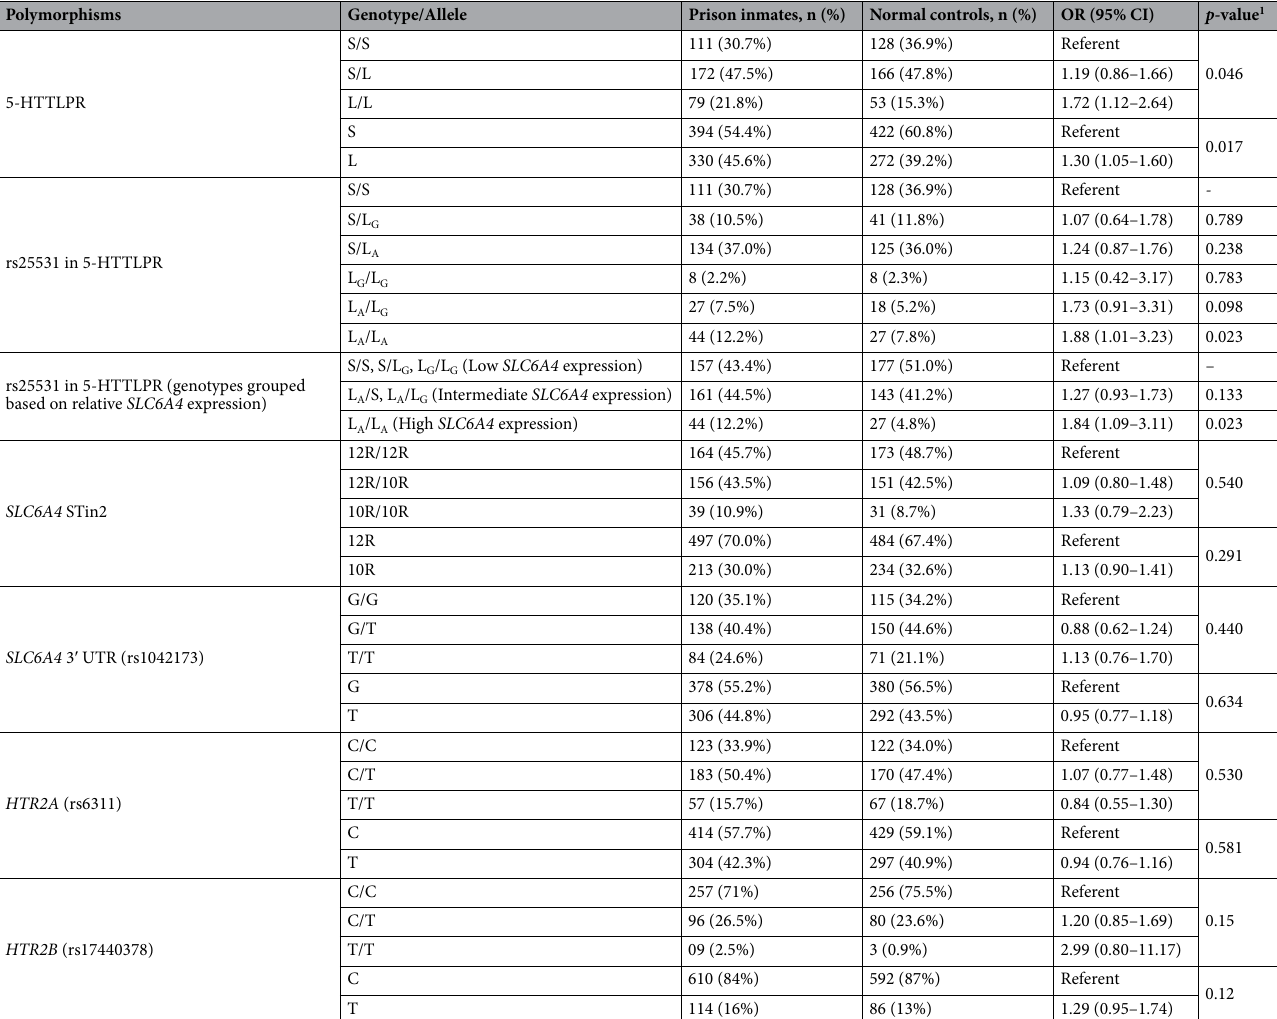
Table 1. Allele and genotype distribution for 5-HTTLPR, rs25531 in 5-HTTLPR, STin2, 3 ʹ UTR (